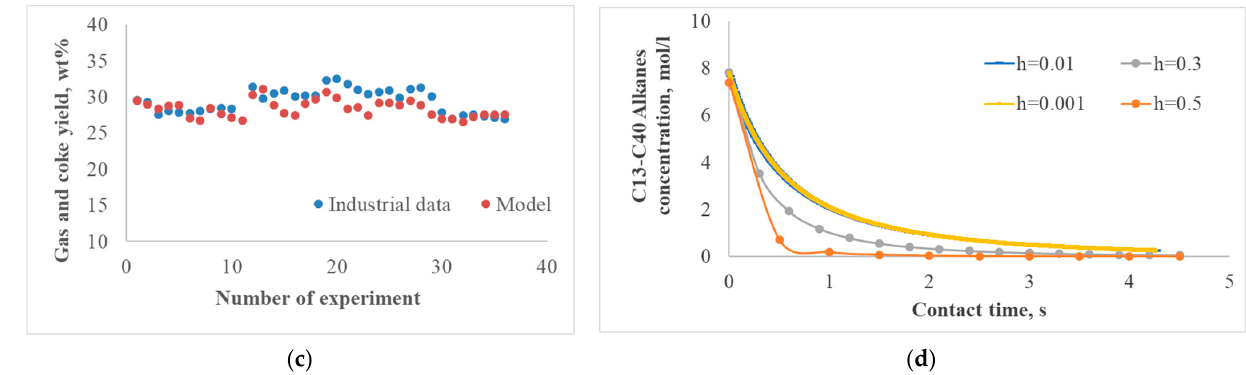
Figure 3. Model and experimental results: ( a ) yields of gasoline; ( b ) light gasoil yield; ( c ) gas and coke yield; and a graph of sensitivity of one component to time step ( d ). Table 5. Change in the major operating variables for model validation. Table 6. Feedstock composition to define the model sensitivity